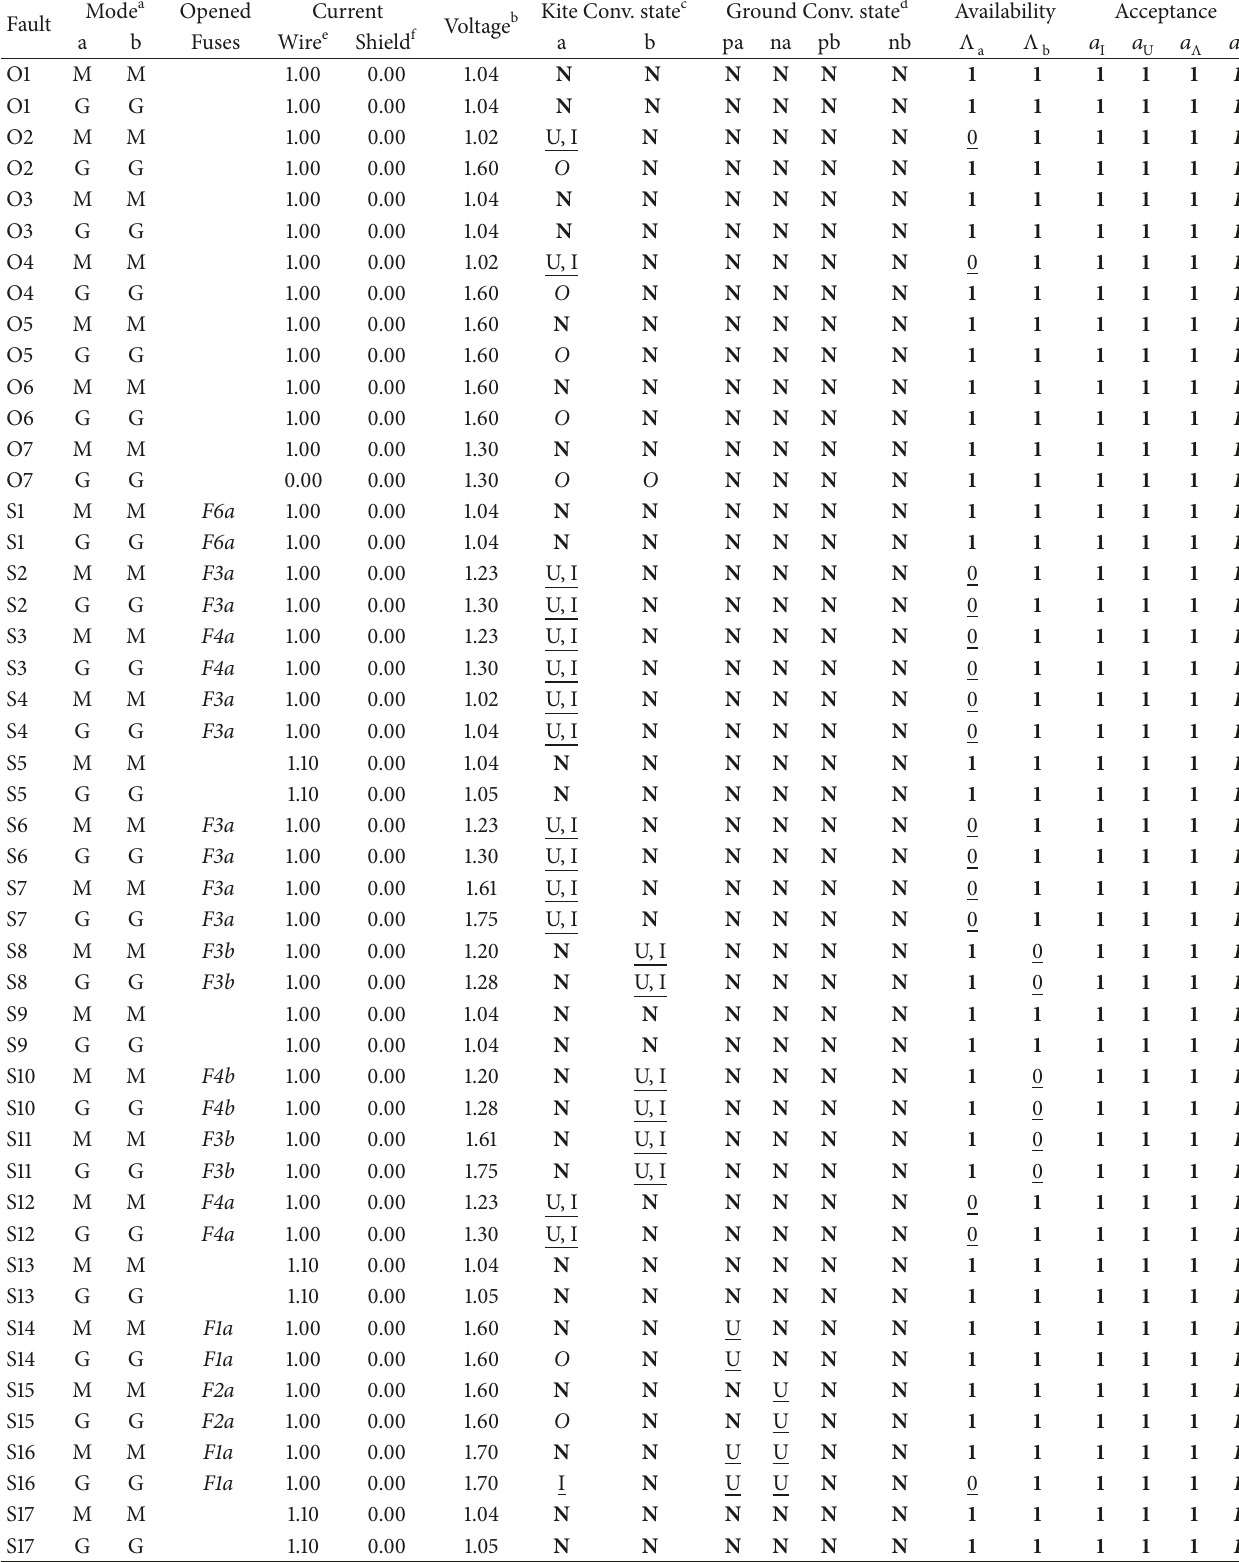
Table 4: Simulation